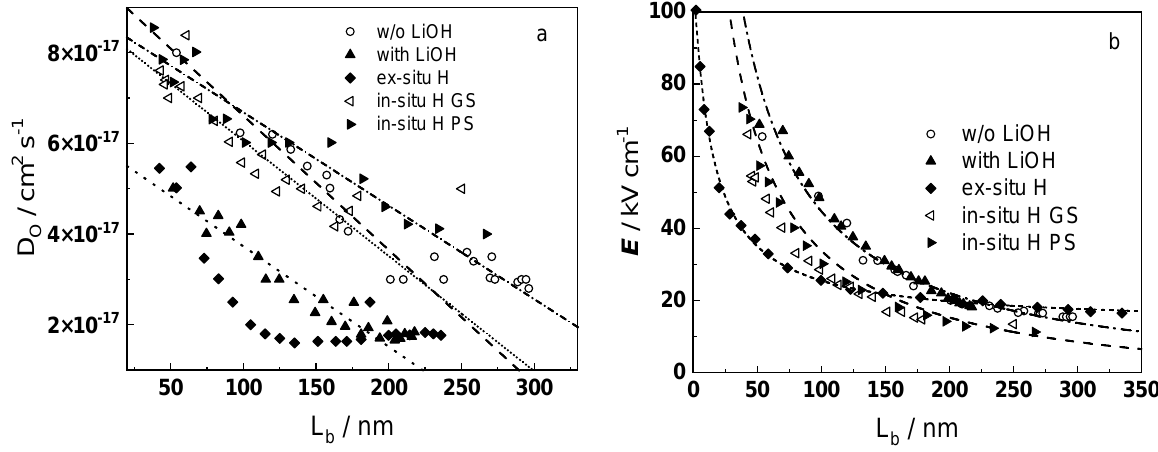
Figure 13. ( a ) Dependence of oxygen diffusion coefficient on oxide thickness under different condi- tions. Points-calculated values based on nonlinear regression of impedance spectra; lines-regression based on the assumption for linear increase of compressive stresses with oxide layer thickness; ( b ) Dependence of the field strength on the thickness of the oxide obtained under different conditions. Points-calculated values based on nonlinear regression of impedance spectra, lines-nonlinear re- gression by Equation (14).